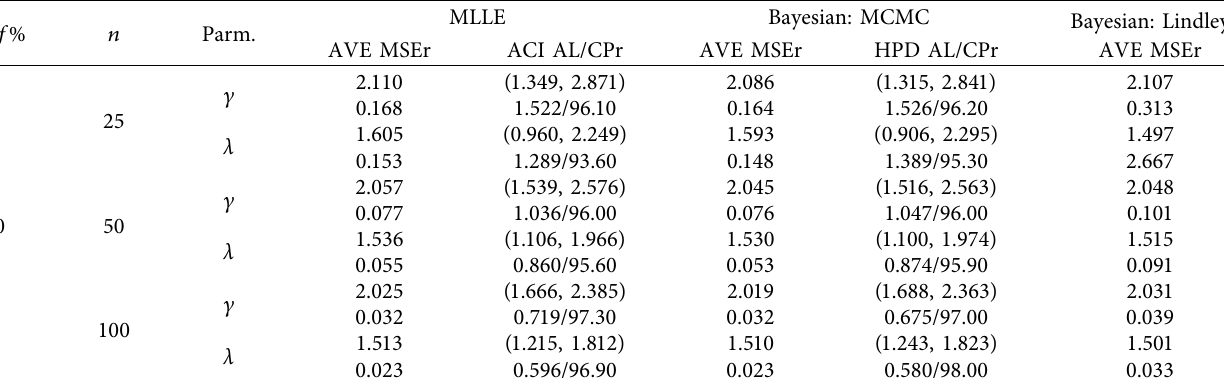
Table 2: Numerical results of AVEs, ACIs, MSErs, ALs, and CPrs (in %) for c � 2 and λ � 1 . 5 under number of stages m � 4. MLLE Bayesian: f % n Parm.